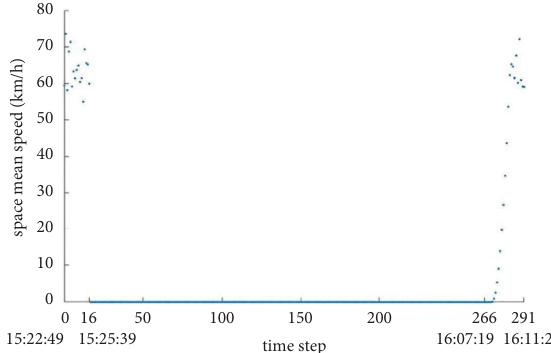
Figure 4: Te state variation of a grid in case study. Table 1: Confusion matrix of classifcation results. Ground-truth